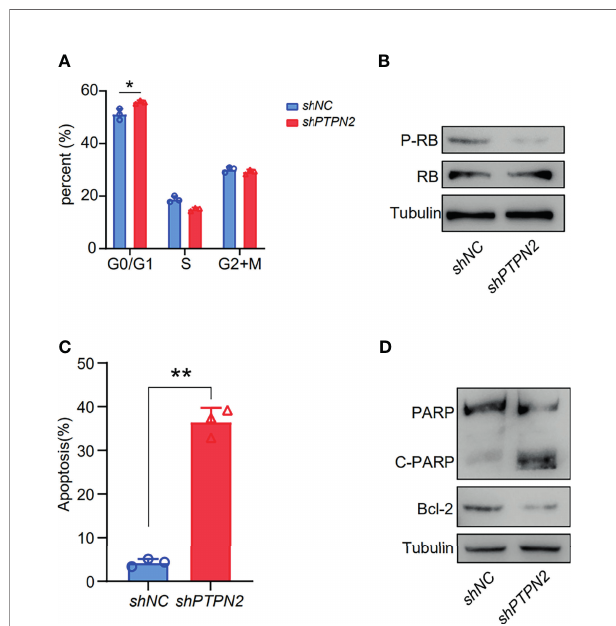
FIGURE 8 | Depletion of PTPN2 induction of cell cycle arrest and apoptosis. (A) Cell cycle phase distribution of PANC-1 PTPN2 KD cells determined by fl ow cytometry. (B) Western blotting analysis of cell cycle related protein changes upon knock-down of PTPN2 . (C) Representative fl ow cytometry plot for quantifying apoptosis in PANC-1 PTPN2 KD and control cells, analyzed by 7-AAD and Annexin V staining. (D) Western blotting analysis of apoptosis related protein changes upon knock-down of PTPN2 . *p < 0.05, **p <